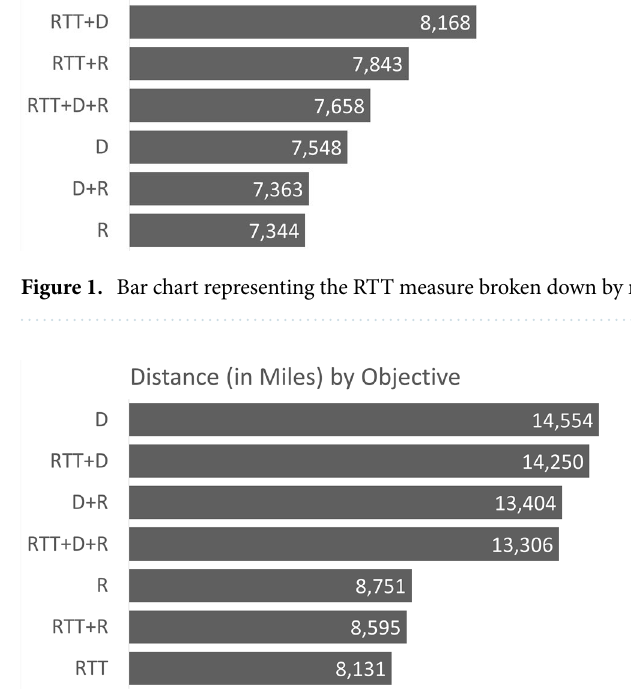
Figure 2. Bar chart representing the distance measure broken down by